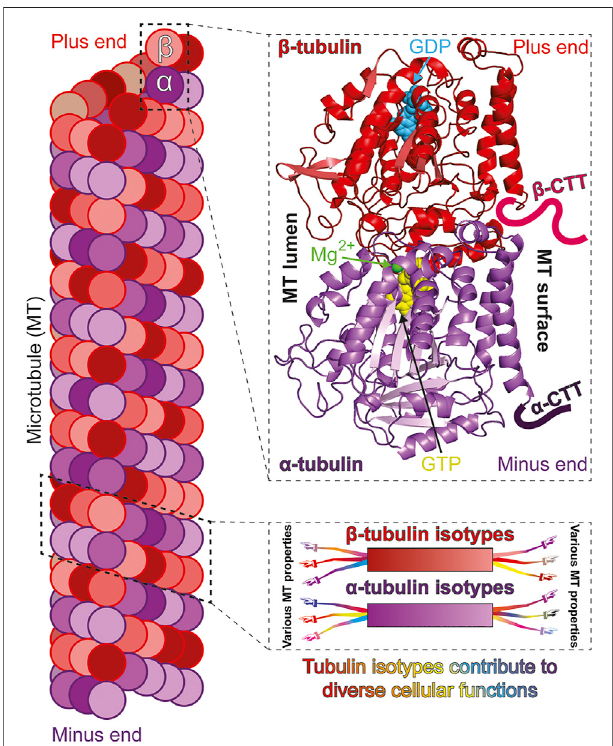
FIGURE 1 | Isotypes of α - and β -tubulin construct functionally diverse microtubules. Microtubules (MTs) polymerize from “ head-to-tail ” binding of tubulin, a heterodimer of α - and β -tubulin subunits (left). Both α - and β -tubulin subunitsbindGTPbut onlythe β -tubulin bound GTPishydrolysableand exchangeable [top-right; cryo-EM structure of S. cerevisiae tubulin, polymerized with GTP in vitro; PDB ID: 5W3F (Howes et al., 2017)]. The carboxy terminal tails (CTTs) are normally unstructured and are only drawn representatively and not to scale. The α - and β -tubulin subunits can be encoded by multiple genes to produce variants, or isotypes (bottom-right; color gradient represents different isotypes). Tubulin isotypes can each possess common and/or unique molecular properties which expands the ability of MTs to optimally perform diverse and specialized functions (represented by arms/hands differentially extending from